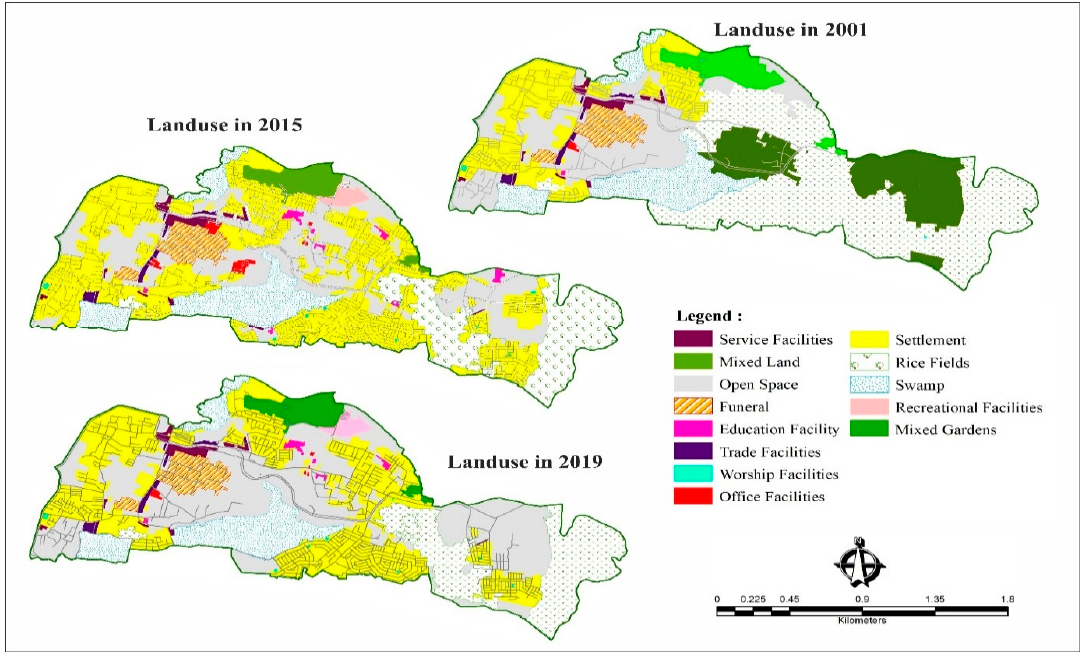
Figure 6. Change to Land Use in the Hertasning-Samata Suburbs. Source: author elaboration,. Map (c) 2001, 2015, 2019 Google.